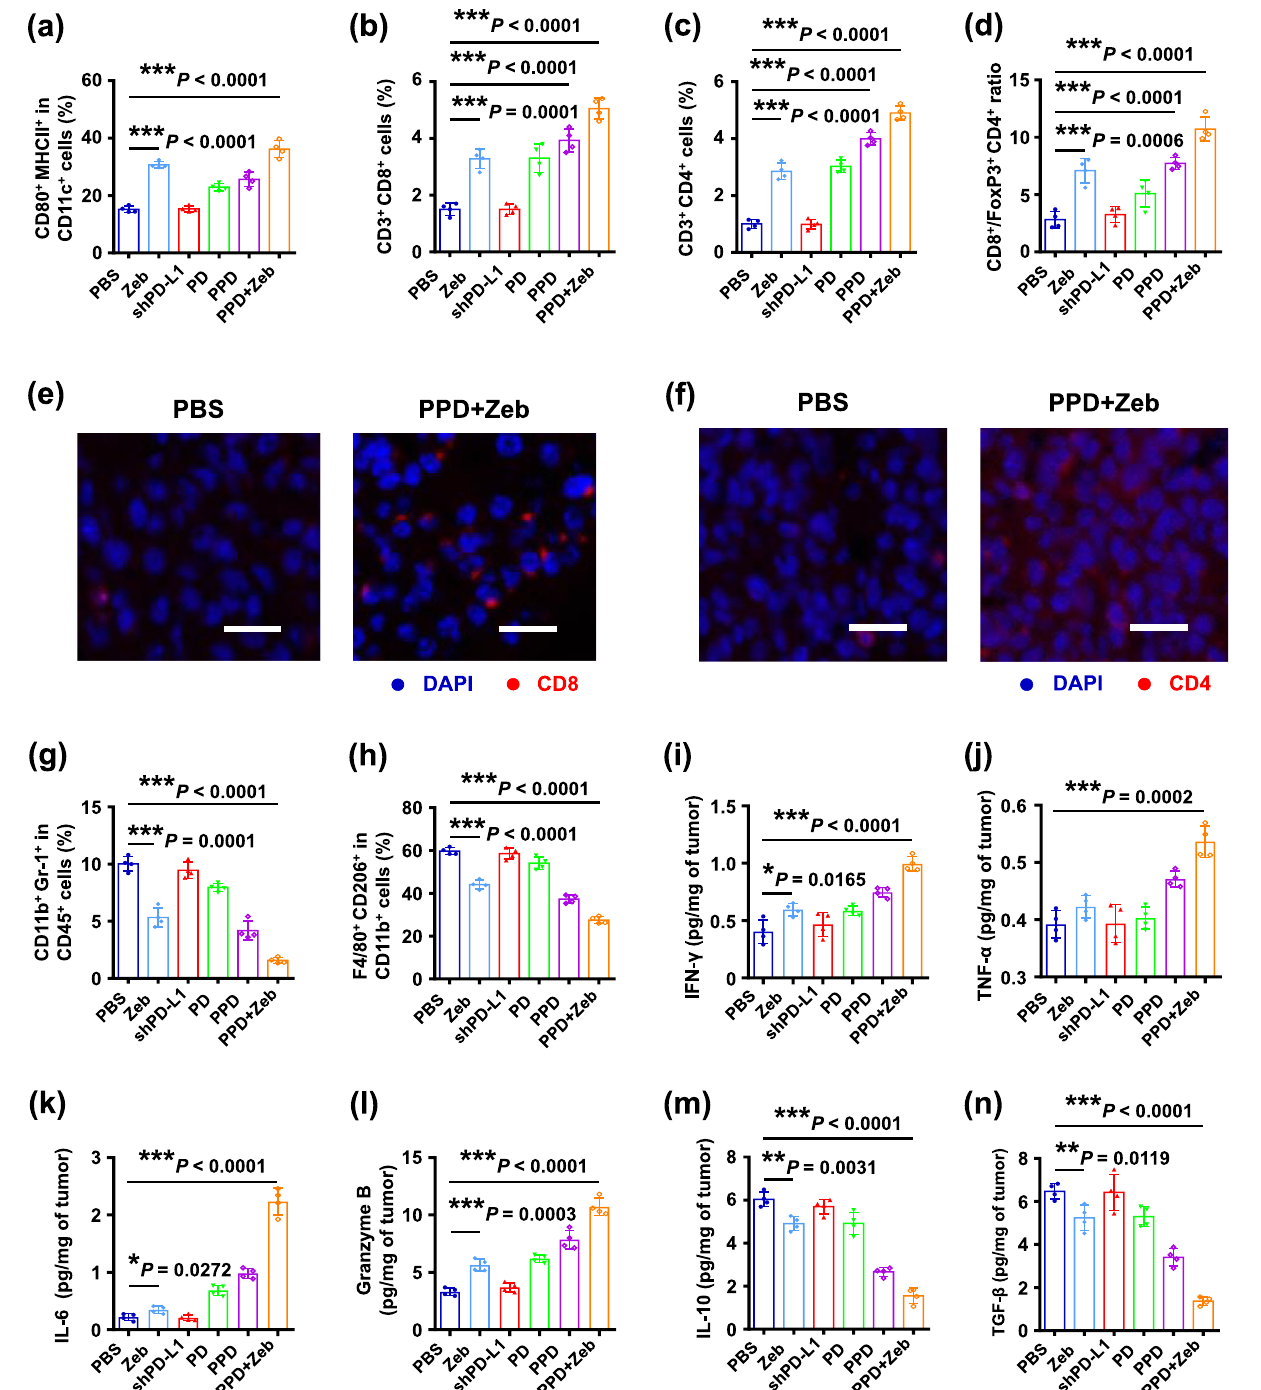
Fig. 4 PPD combined with zebularine induced signi fi cant anti-tumour immune response. a Percentages of CD80 + MHC II + dendritic cells gating on CD11c + cells in lymph nodes of B16F10 tumour-bearing mice after different treatments. b Percentages of CD3 + CD8 + T cells gating on CD45 + cells in tumour of B16F10 tumour-bearing mice receiving different treatments. c Percentages of CD3 + CD4 + T cells gating on CD45 + cells in tumour of B16F10 tumour-bearing mice after treatment. d Ratios of CD8 + T/Foxp3 + CD4 + T in tumours of B16F10 tumour-bearing mice receiving different treatments. e Representative immuno fl uorescence images of CD8 + T cells in tumours of B16F10 tumour-bearing mice after treatment, scale bar: 20 μ m. f Representative immuno fl uorescence images of CD4 + T cells in tumours of B16F10 tumour-bearing mice after treatment, scale bar: 20 μ m. g Percentages of CD11b + Gr-1 + cells gating on CD45 + cells in tumours of B16F10 tumour-bearing mice receiving different treatments. h Percentages of CD206 + F4/80 + cells gating CD11b + cells in tumours of B16F10 tumour-bearing mice receiving different treatments. Levels of cytokine including i IFN- γ , j TNF- α , k IL-6, l Granzyme B, m IL-10, and n TGF- β in tumours of B16F10 tumour-bearing mice after treatment. Data in a – d and g – n are presented as mean ± SD, n = 4 biologically independent samples in a – d and g – n , P -values are calculated by the two-tailed Student ’ s t -test in a – d and g – n as indicated in the fi gures. * P < 0.05, ** P < 0.01, and *** P < 0.001. A representative image of three independent samples from each group is shown in e and f .